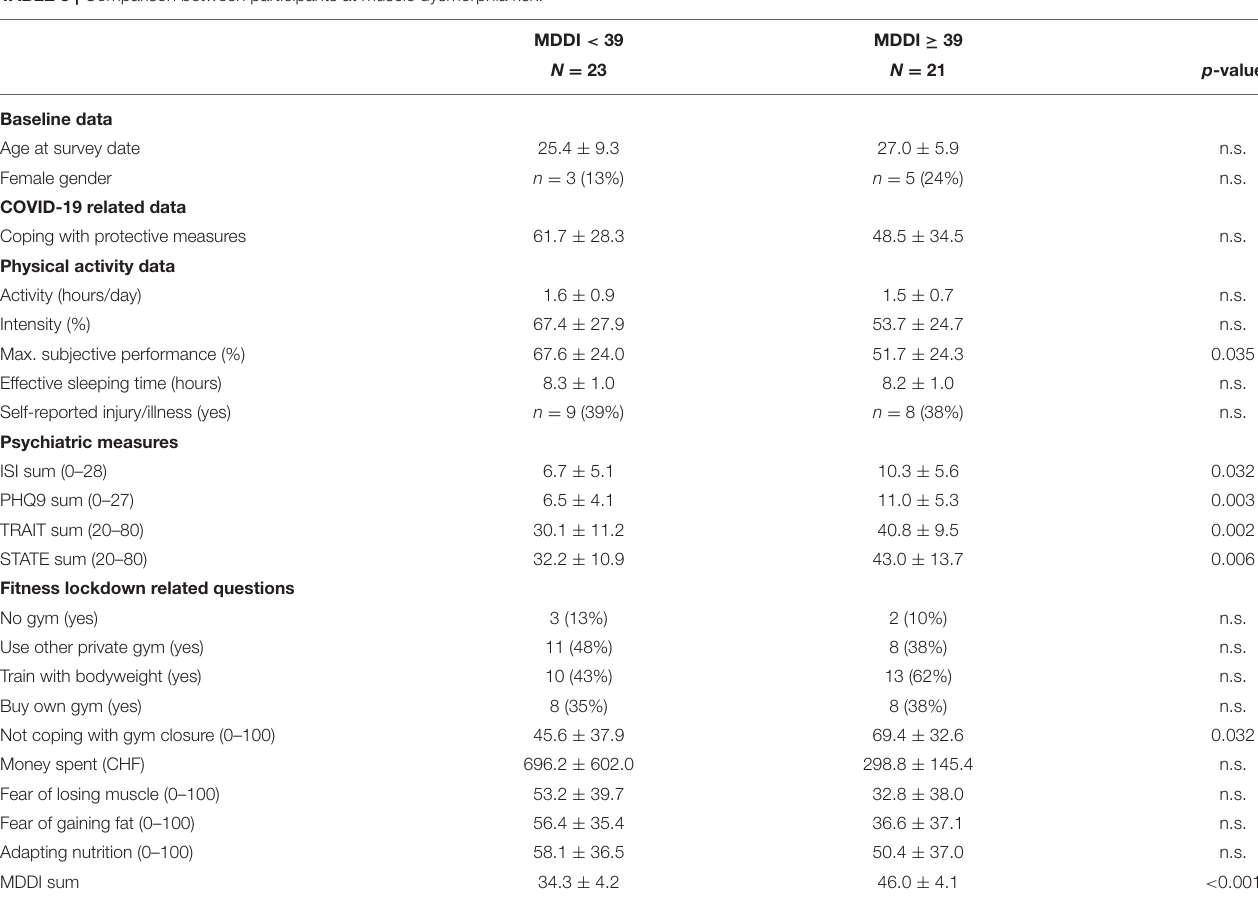
TABLE 3 | Comparison between participants at muscle dysmorphia